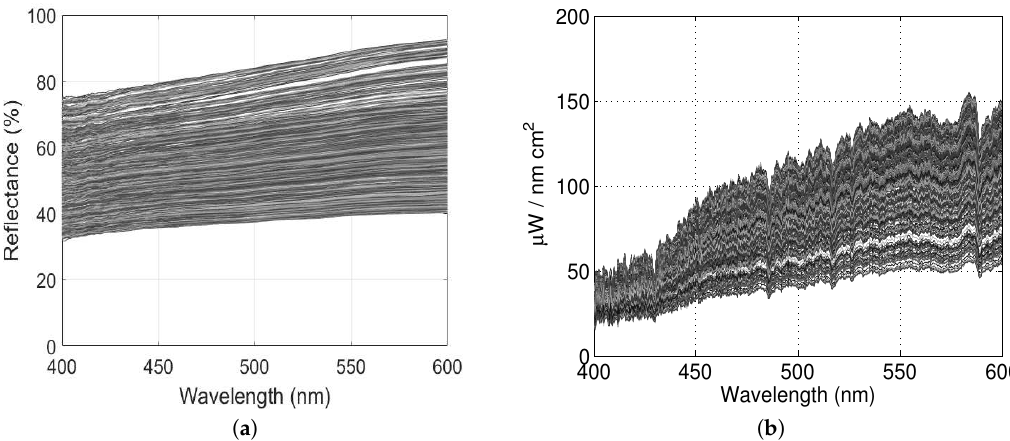
Figure 2. ( a ) Volcanic ash reflectance (in %) measured in the laboratory and ( b ) training spectral data L , as measured by the